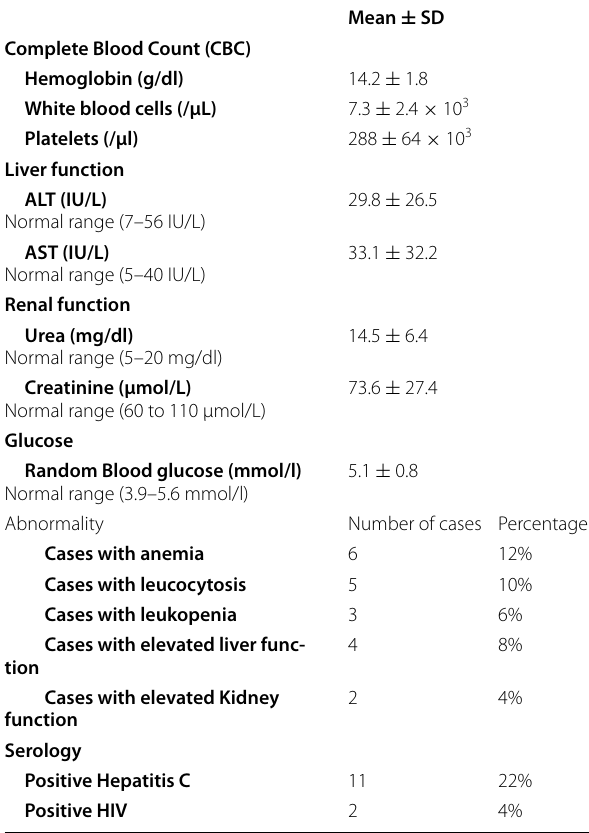
Table 8 Results of laboratory investigations of the